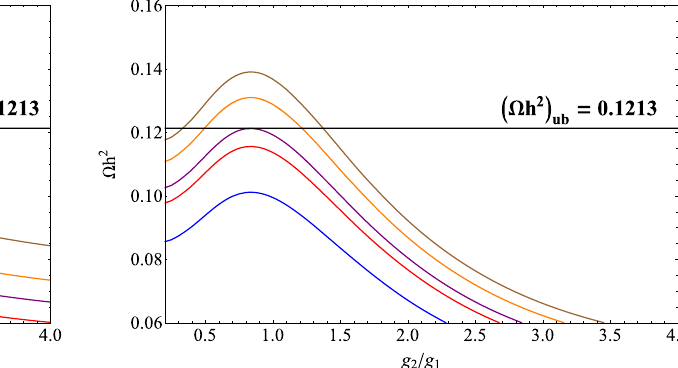
izontal line represents the upper bound of the DM relic abundance. Top-left panel: z 1 = 1 / 4 and z 2 = 1 / 8. Top-right panel: z 1 = 1 / 5 and